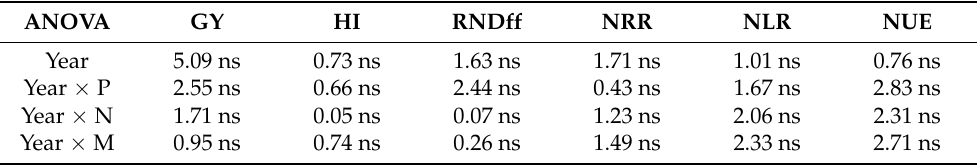
Table 2. Analysis of variance on rice yield and NDff of rice between 2018–2019 and previous crop and N rate and N fertilizer management (F values).